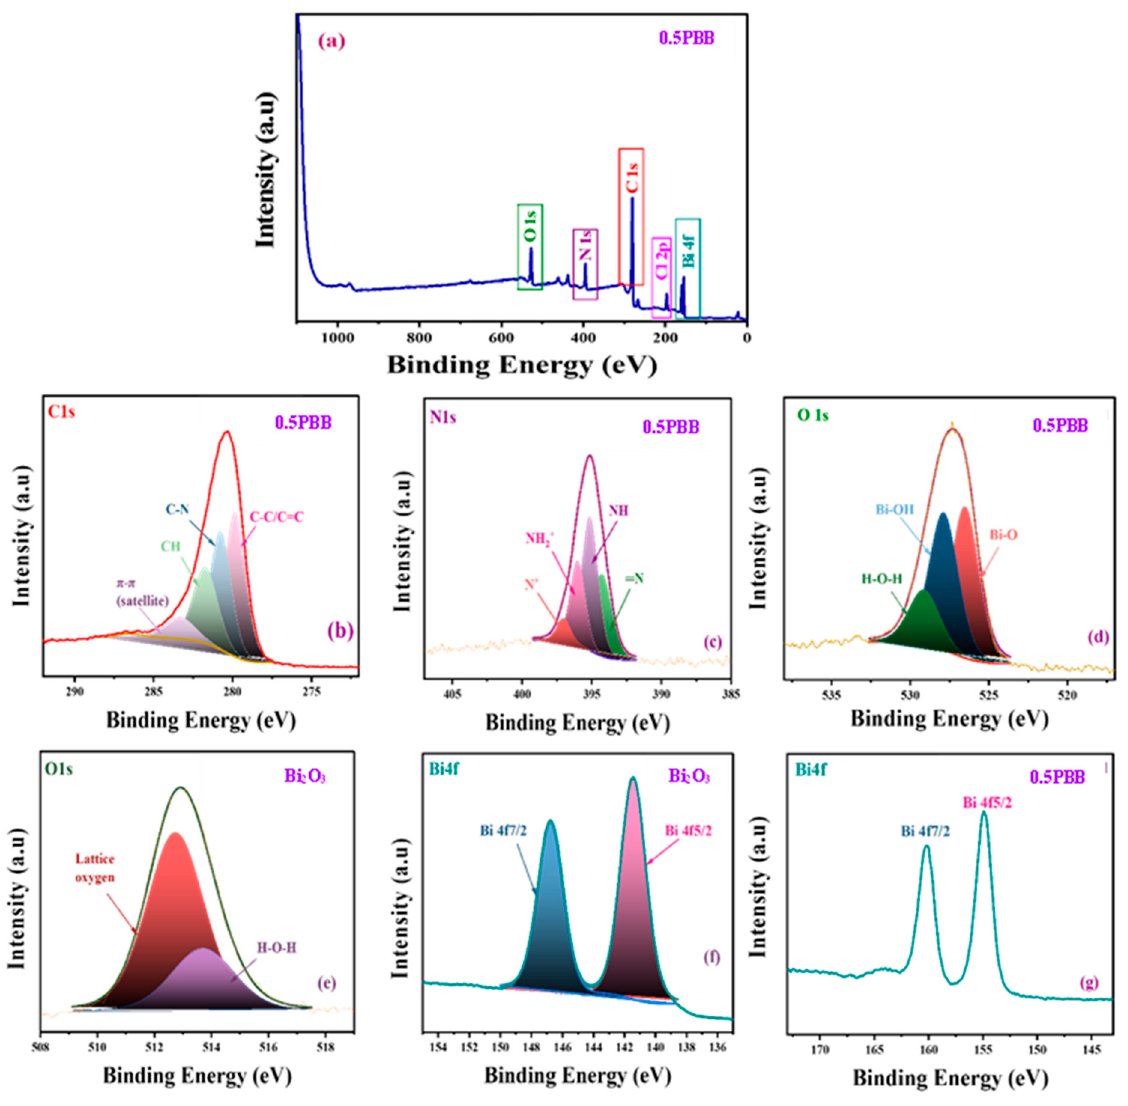
Figure 5. XPS results of ( a ) survey spectra of 0.5PBB. HR spectra of ( b ) C 1s, ( c ), N1s, ( d ), ( e ) O1s, and ( f ), ( g ) Bi4f of Bi 2 O 3 and 0.5PBB composite.